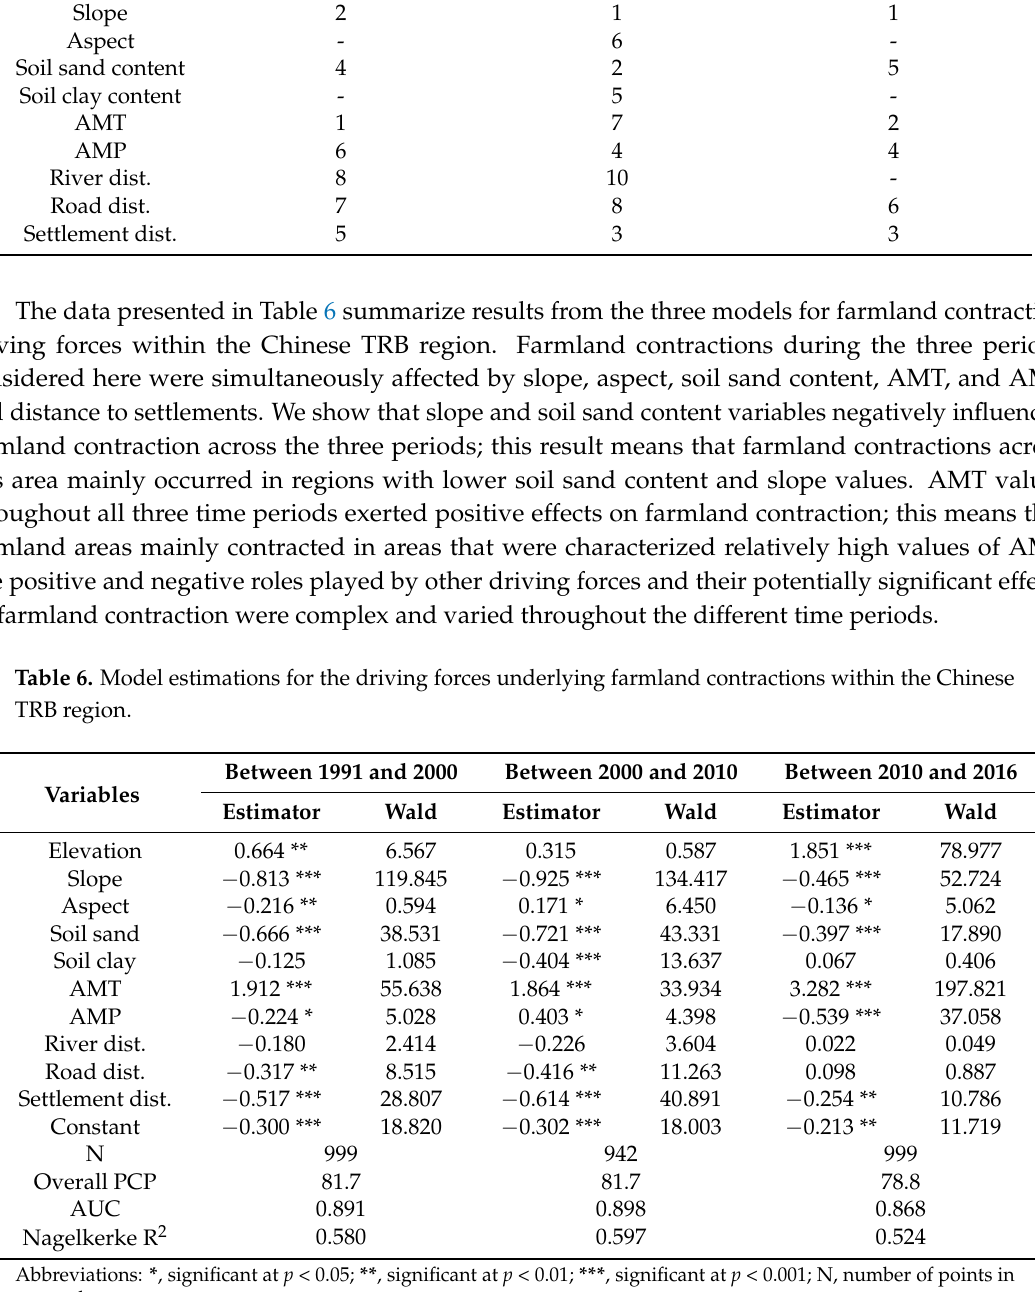
River dist. Road dist. Settlement